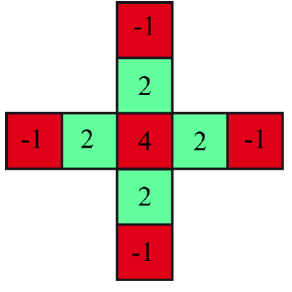
Figure 8. Example of a demosaicing pattern and coefficients corresponding to Malvar et al. [17] from Microsoft